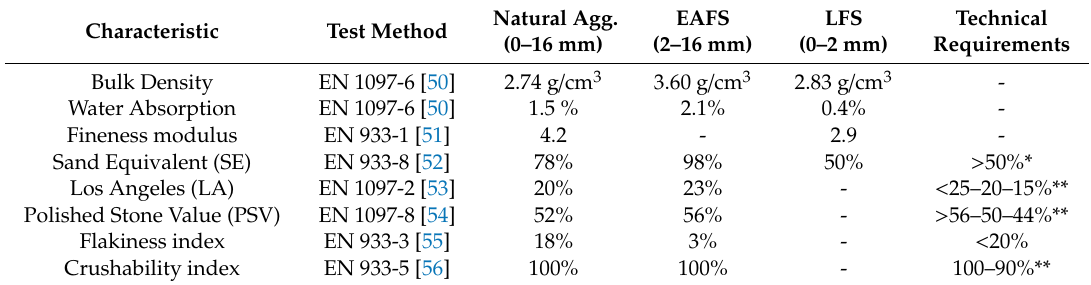
Table 1. Physical properties of the siliceous aggregate, the EAFS, and the LFS.